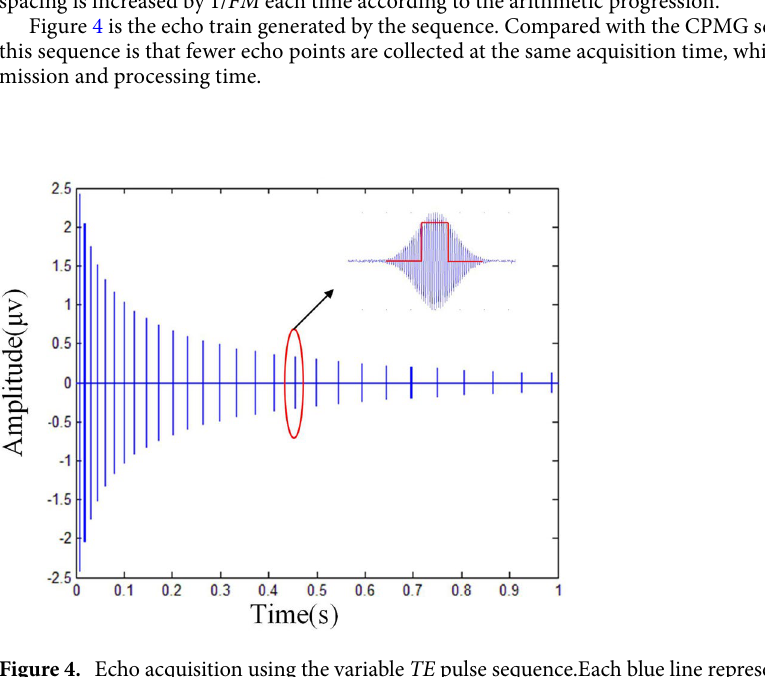
Figure 4. Echo acquisition using the variable TE pulse sequence.Each blue line represents the echo that appears after the 180° pulse, and the echo width is the same as the 180° pulse width, but only 32 echo cycles (about 64 μs) are acquired by opening the acquisition window, echo amplitude is considered to be uniform in this